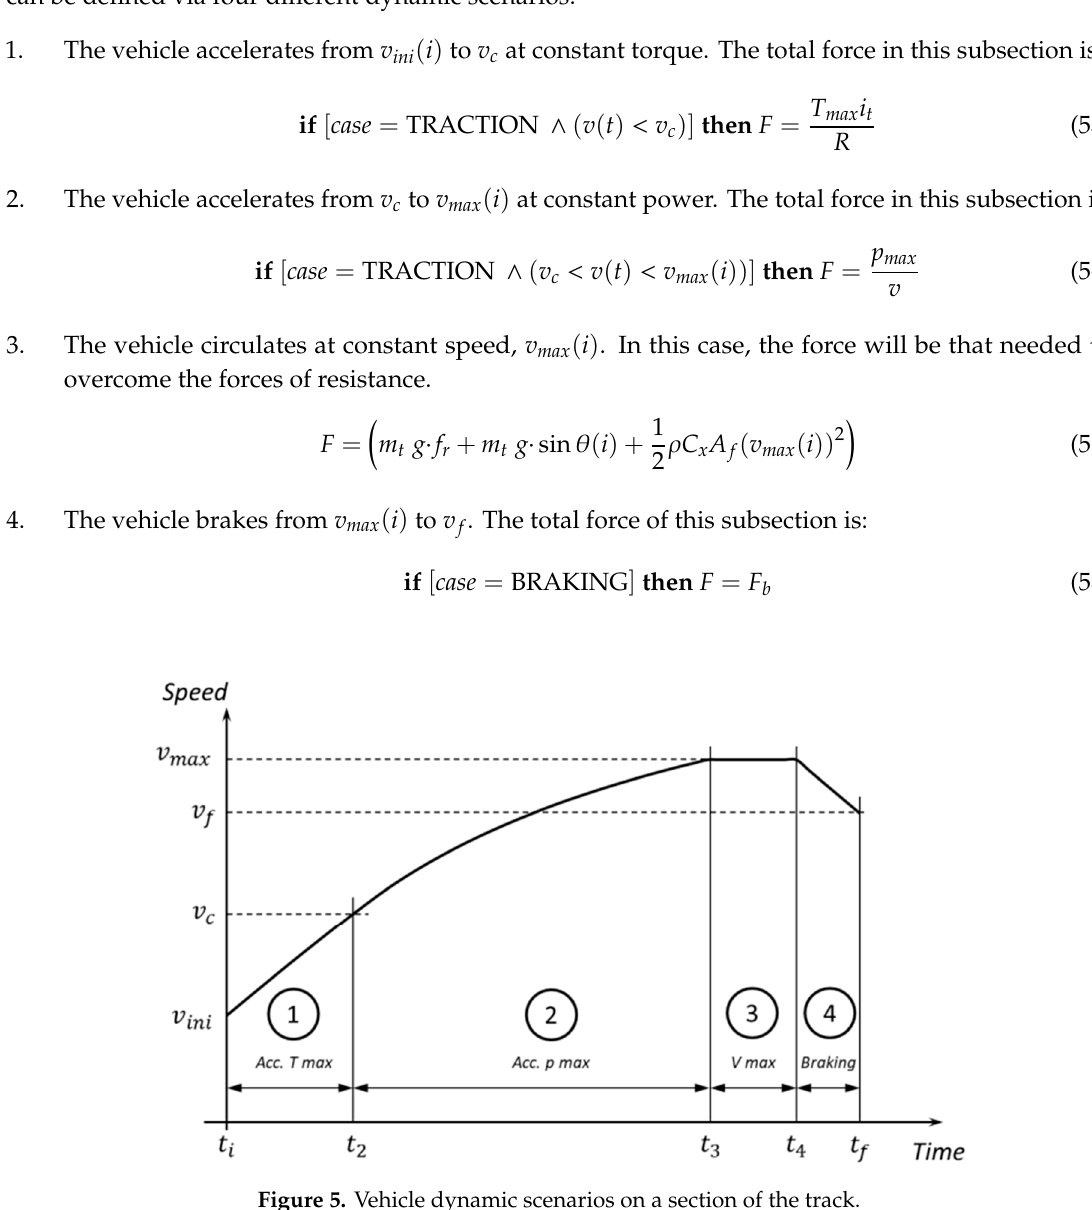
Figure 5. Vehicle dynamic scenarios on a section of the track.